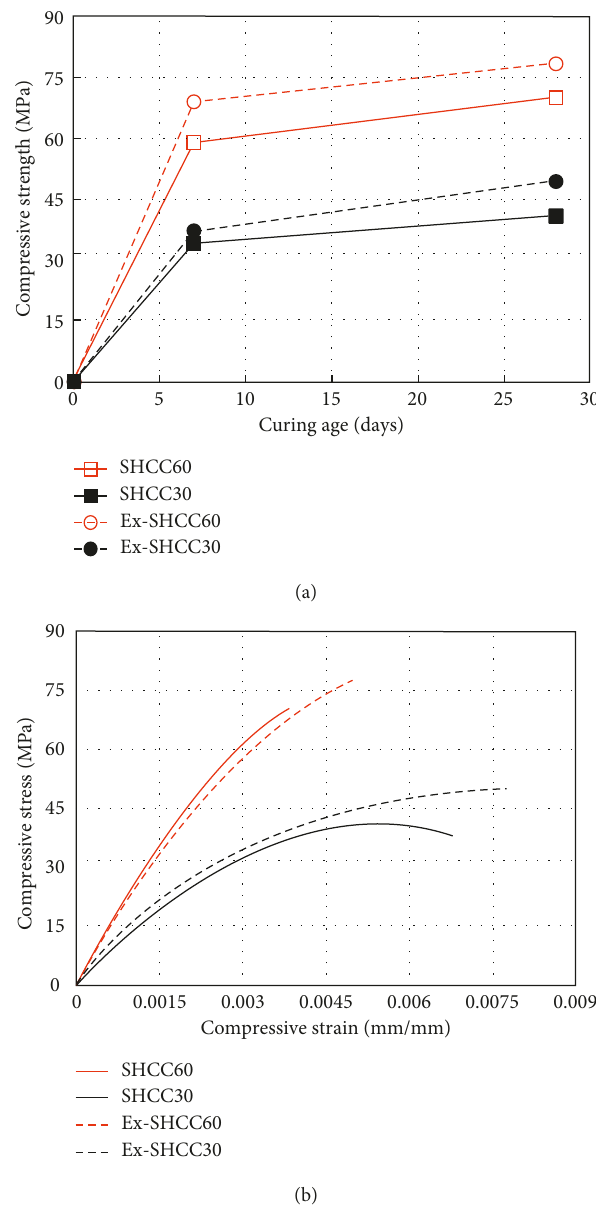
Figure 3: Effects of expansive admixture on compressive properties of SHCC and Ex-SHCC mixtures. (a) Effects of curing age on compressive strength. (b) Compressive response of SHCC and Ex-SHCC